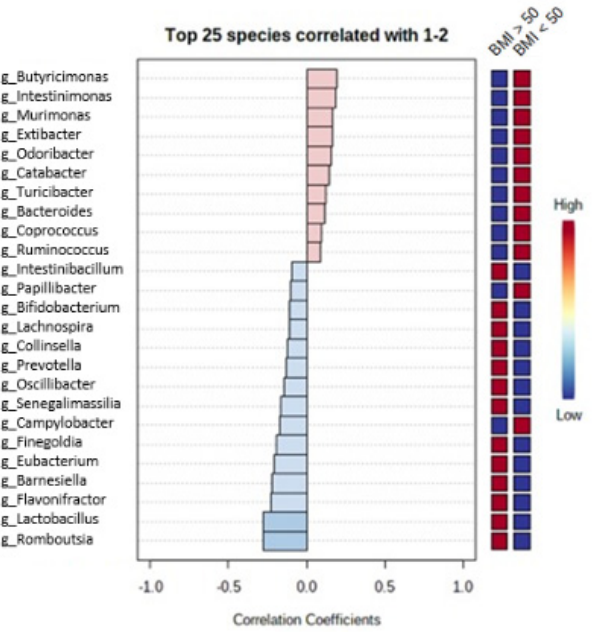
Figure 4. Differences in fecal microbiota between the patients with BMI above 50 kg/m 2 vs. the other patients with obesity.